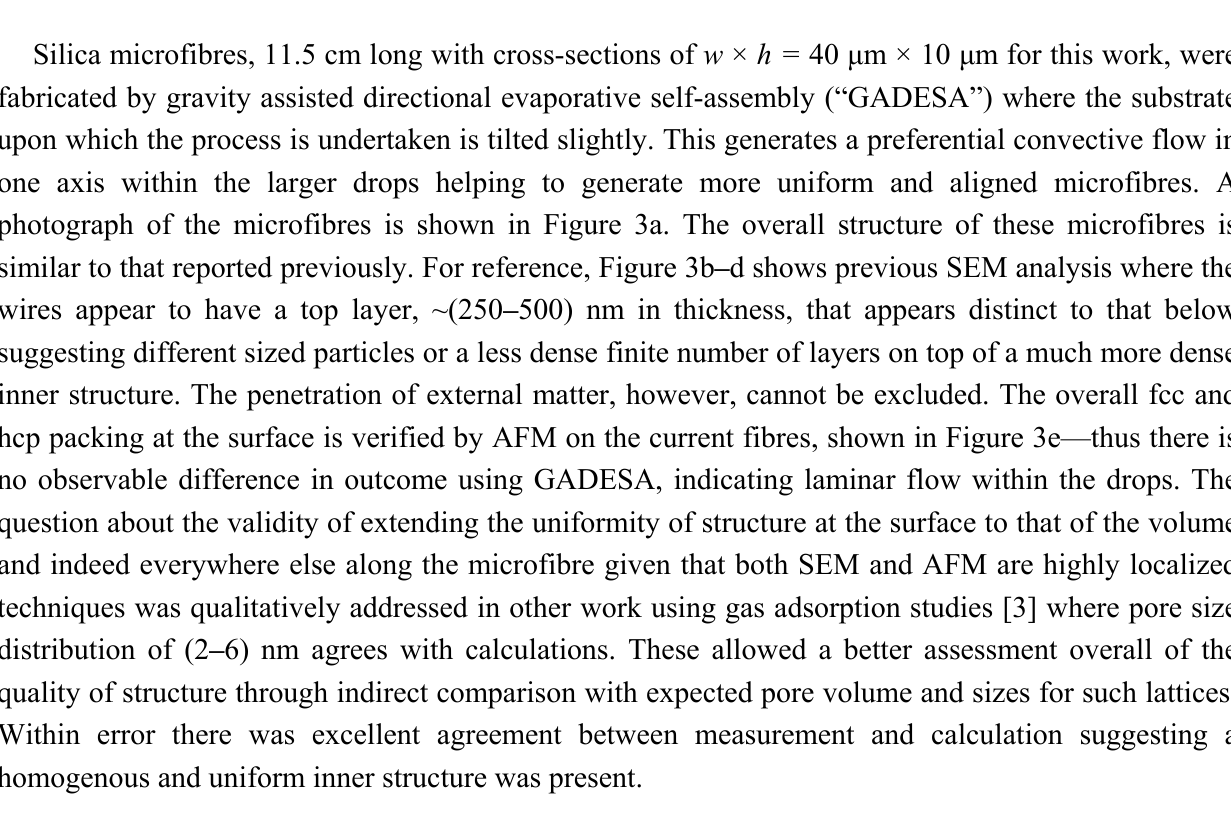
Figure 3. Surface characterisation of a self-assembled silica microwire: ( a ) optical micrograph of long wires produced using gravity assisted deposition by